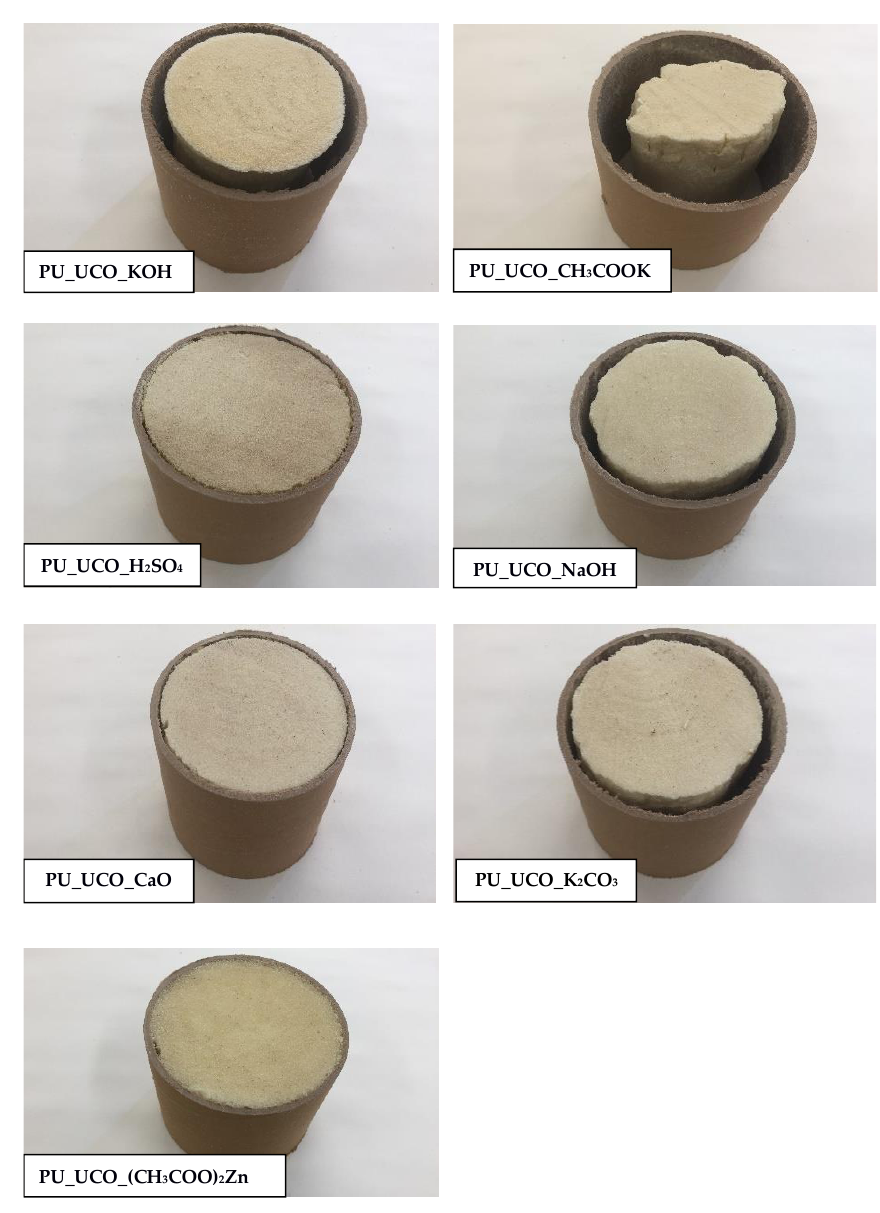
Figure 8. Cross-sections of polyurethane foams obtained with various bio-polyols.